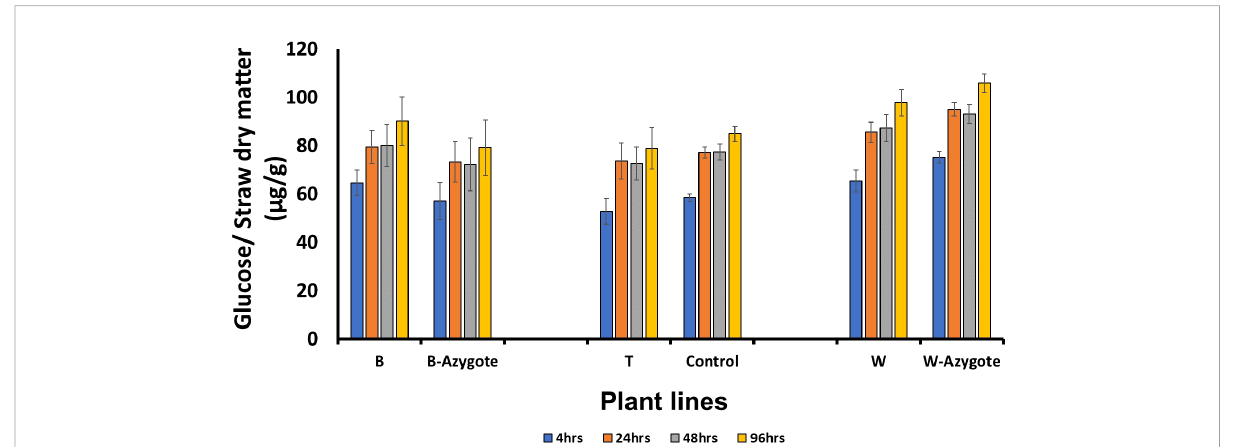
FIGURE 5 Sacchari fi cation following hot water pretreatment. No signi fi cant differences (P < 0.05) were identi fi ed following Student ’ s t ‐ test. B, T, W are RNAi lines; B-azygote, W-azygote are corresponding azygote lines; for line T where no azygotes were available, empty vector and wild type plants were used as controls. The error bars represent standard errors between biological triplicates (i.e. independent